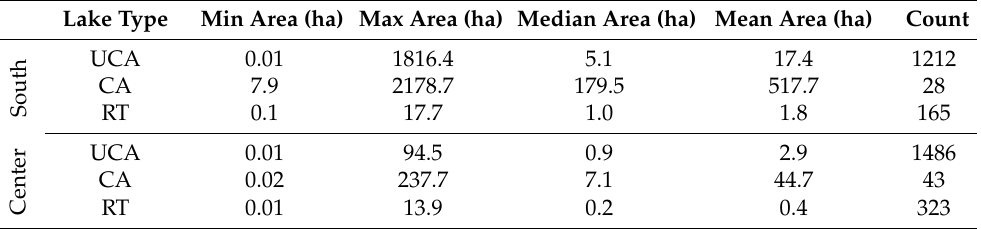
Table 3. Lake type statistics based on the 2019 (June 17) scene. Lake